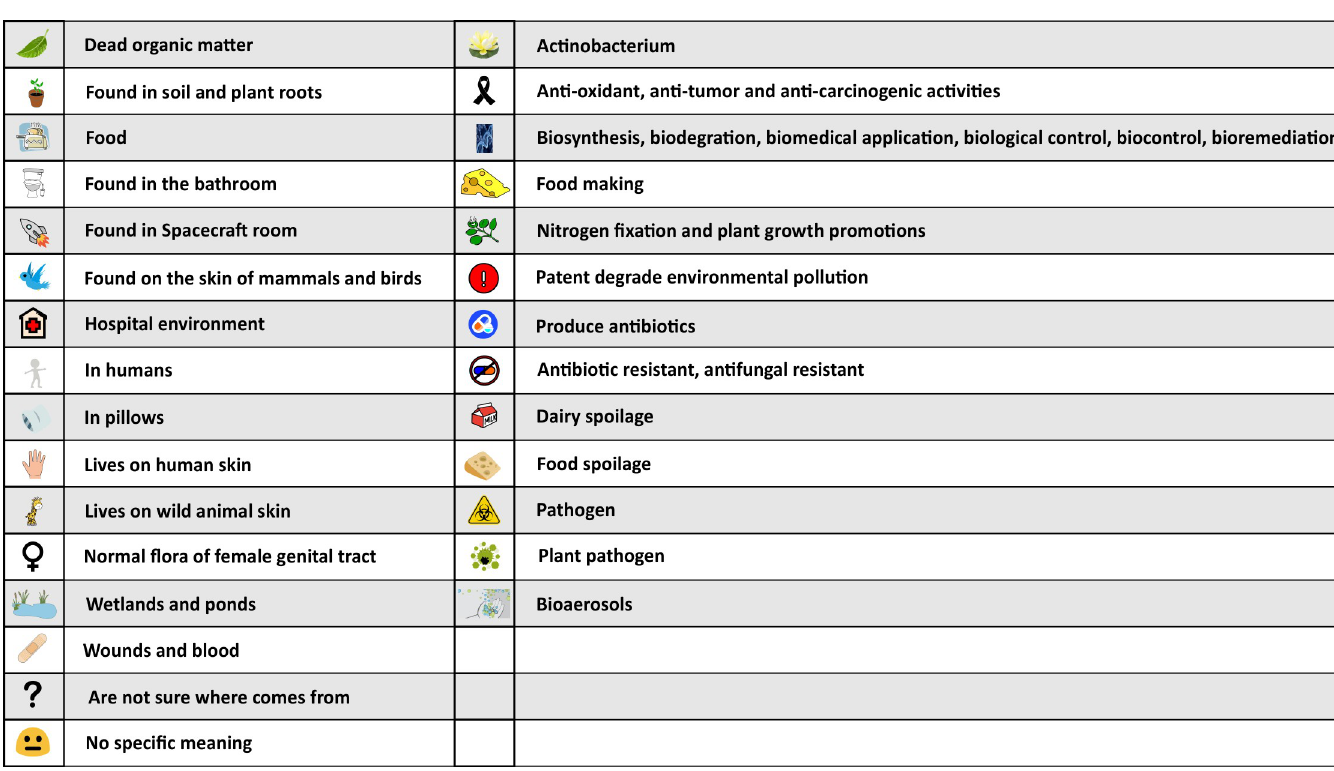
Fig 2. Symbol key. These symbols are used in Fig 3 to link the microorganisms to their possible origins (from ‘Dead organic matter’ to ‘Wounds and blood), interest (from “Not sure where it comes from’ to ‘No specific meaning’), and importance (from ‘Actinobacterium’ to ‘Bioaerosols’).